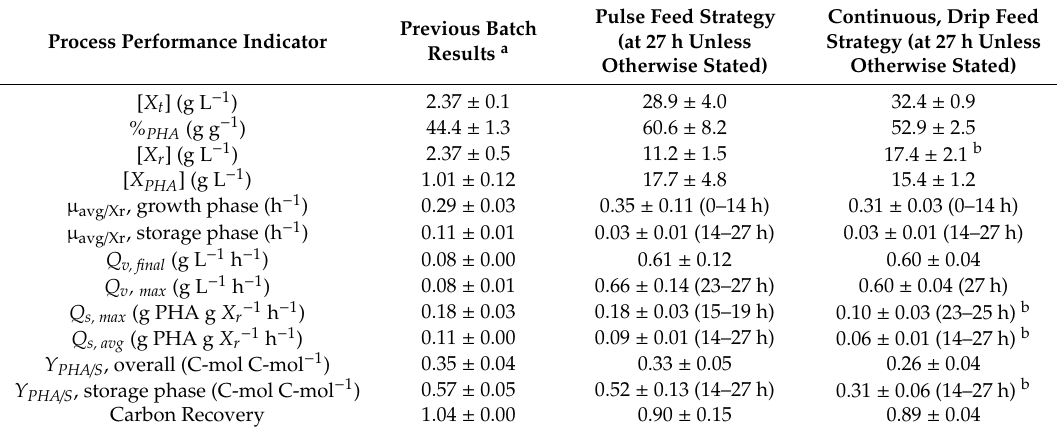
Figure 4. Growth curves shown for continuous drip strategy derived from modeled feeding rates. Error bars represent standard deviations between three biological replicates. Table 2. Comparison of key process performance indicators of previous batch cultivations with the current fed-batch process.